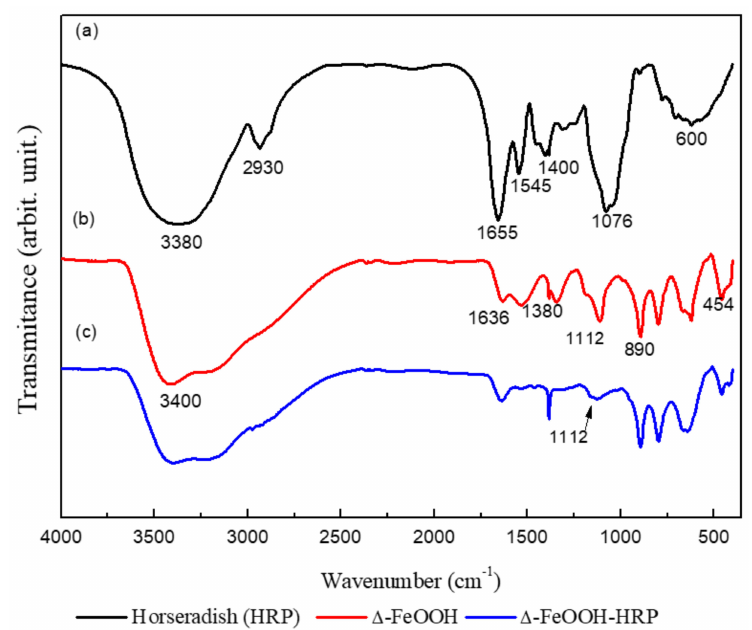
Figure 2. Fourier transform infrared spectroscopy (FTIR) spectra: ( a ) horseradish peroxidase (HRP); ( b ) ∆ -FeOOH particles; and ( c ) ∆ -FeOOH–HRP.